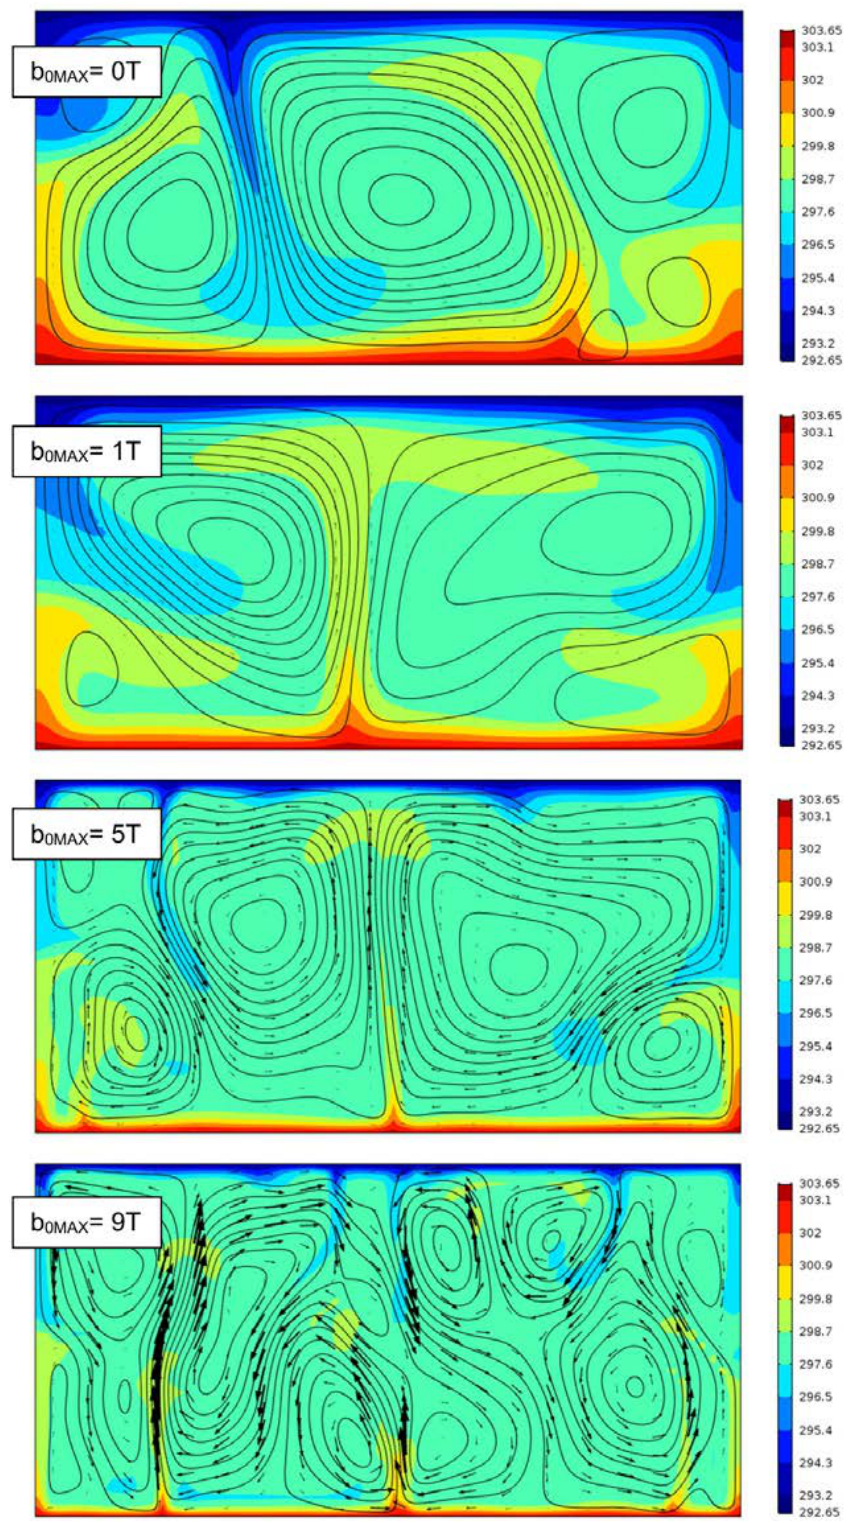
Figure 18. Temperature color maps with stream lines and velocity vectors for numerical simulations for Δ T = 11 °C.